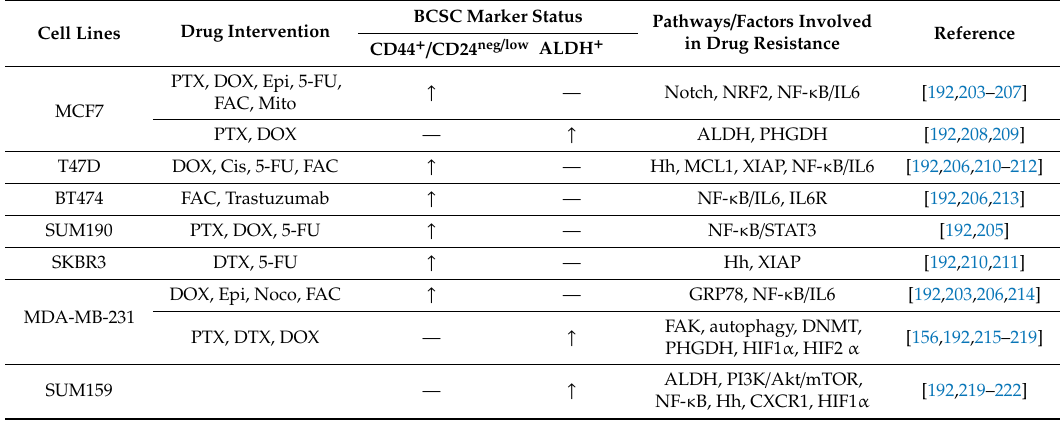
Table 1. Commonly used chemotherapeutic drugs in breast cancer and pathways or factors involved in drug